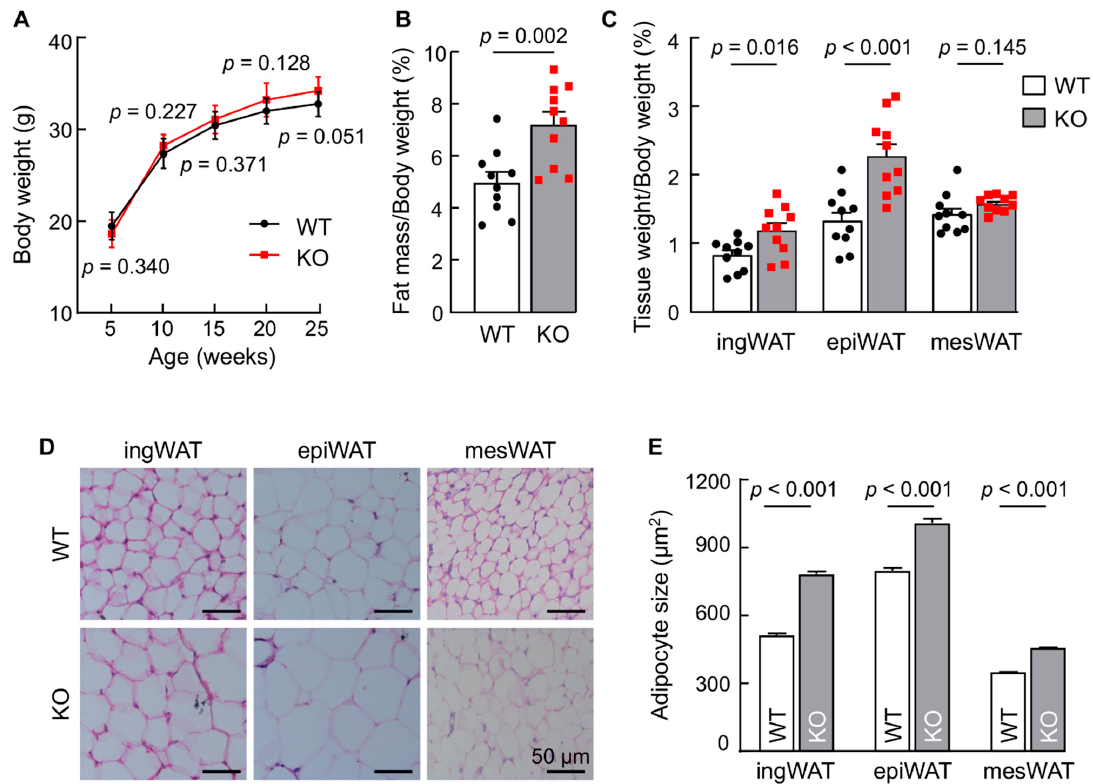
Figure 1. Body and adipose tissue weights and adipocyte sizes in WT and corin KO mice. ( A ) Body weights in male WT and corin KO mice on chow diet were measured between 5 to 25 weeks of age ( n = 9). p values between the two groups at the same age are indicated. ( B , C ) Ratios of total adipose mass vs. body weight ( B ) and ingWAT, epiWAT, and mesWAT weights vs. body weight ( C ) were analyzed in 4-month-old male WT and corin KO mice ( n = 10). ( D ) Histology of ingWAT, epiWAT, and mesWAT in H&E-stained sections from WT and corin KO mice (males, 4 months old). Scale bars: 50 µ m. ( E ) Adipocyte sizes in ingWAT, epiWAT, and mesWAT from 4-month-old WT and corin KO mice. At least 100 adipocytes per mouse and 4–6 mice per group were analyzed using Image Pro software. Each group includes at least 600 cells. Individual cell data are not shown. ingWAT: inguinal WAT, epiWAT: epididymal WAT, mesWAT: mesenteric WAT. Data are mean ± SD ( A ) or SEM ( B , C , E ). p values were analyzed by Student’s t test ( A – C ) or Mann-Whitney test ( E